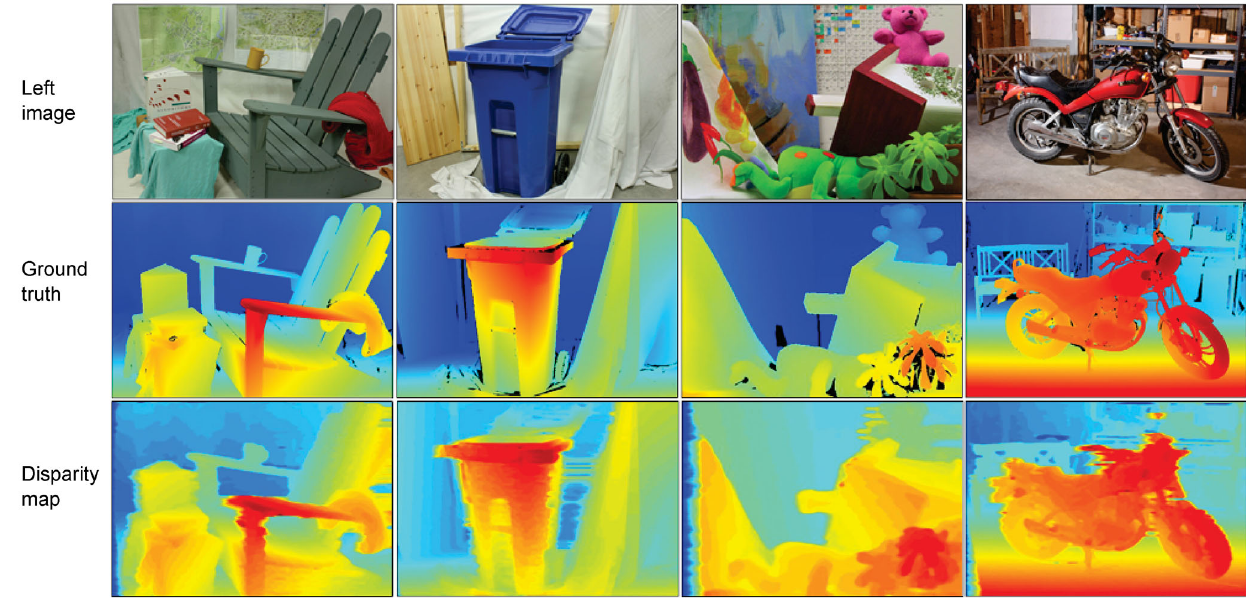
Fig. 4 Some disparity maps obtained for